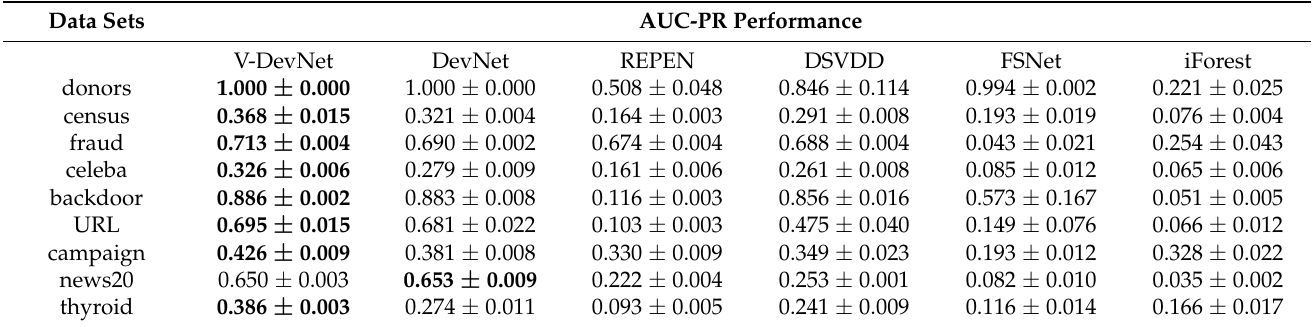
Table 2. AUC-PR performance of V-DevNet and five competitive methods. The bolded data in the table indicates that the accuracy of the algorithm is higher compared to other